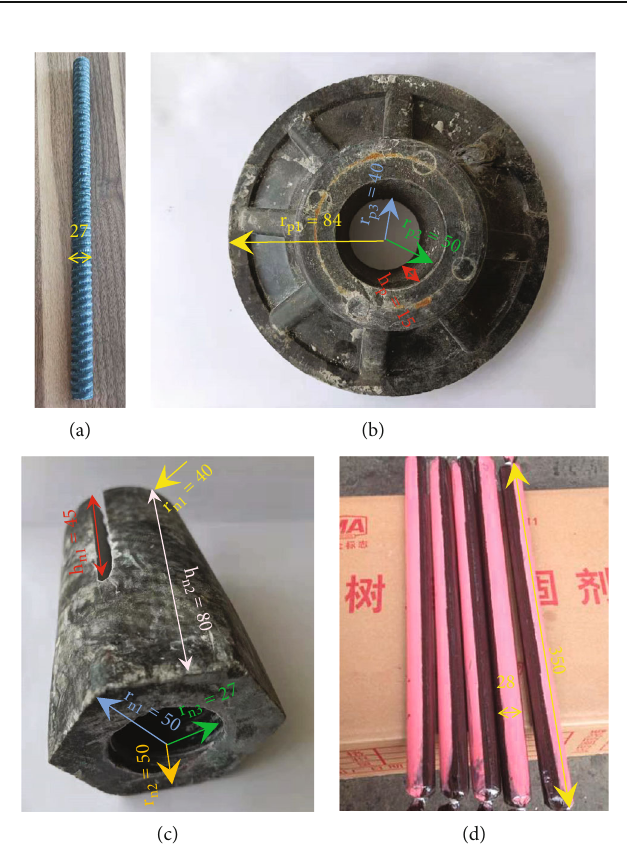
Figure 2: Test material (unit: mm). (a) Anchor rod. (b) Anchor washer. (c) Nut. (d) Resin anchoring